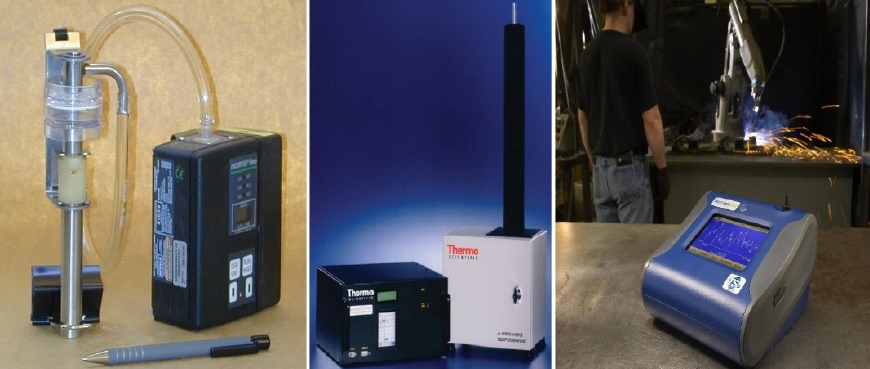
Figure 1. Devices used in PM measurement campaigns conducted within the Parisian underground subway: Left: Gravimetric method equipment [41]; Middle: TEOM (model: 1400; brand: Thermo Scientific); Right: DustTrack (model: DRX; brand: TSI).